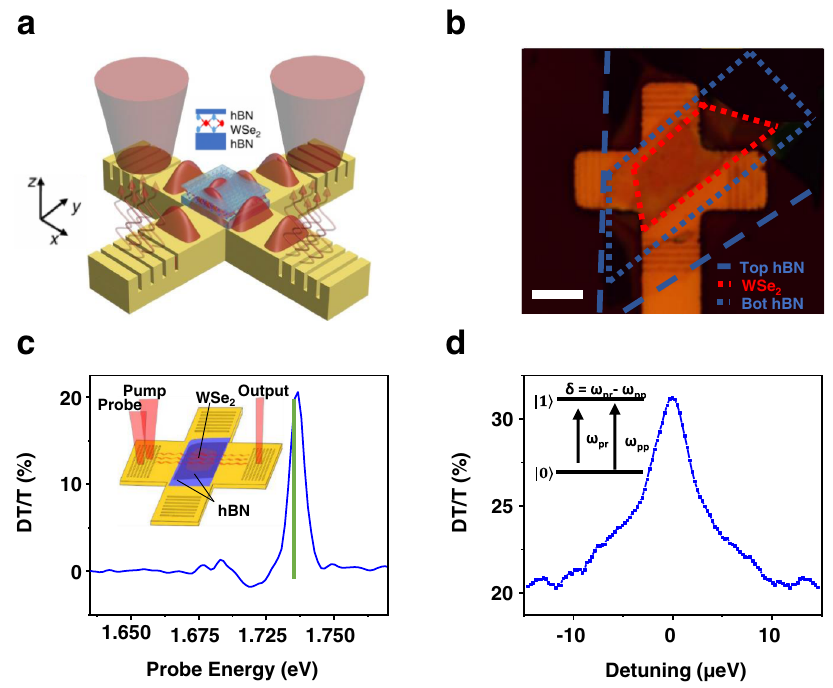
Fig. 1 | Coherent population oscillations of excitons in 2D plasmonic struc- tures. a Depiction of the 2D material plasmonic structure. Surface plasmon polaritons (SPPs) are launched at the input of the device by focusing a free space laser onto either/both input couplers. The SPPs propagate through the waveguide wheretheyinteractwithexcitonsintheWSe 2 monolayer,encapsulatedinhBN.The SPPs are coupled back to free space photons by the output gratings. The upper insetdepictsthehBN-WSe 2 -hBNheterostructureontopofthewaveguide.Theaxes used for the theory and simulations are shown. b Optical imageof the main device usedintheexperiments.Scalebar5 µ m.Thereddottedlinesshowtheactiveregion